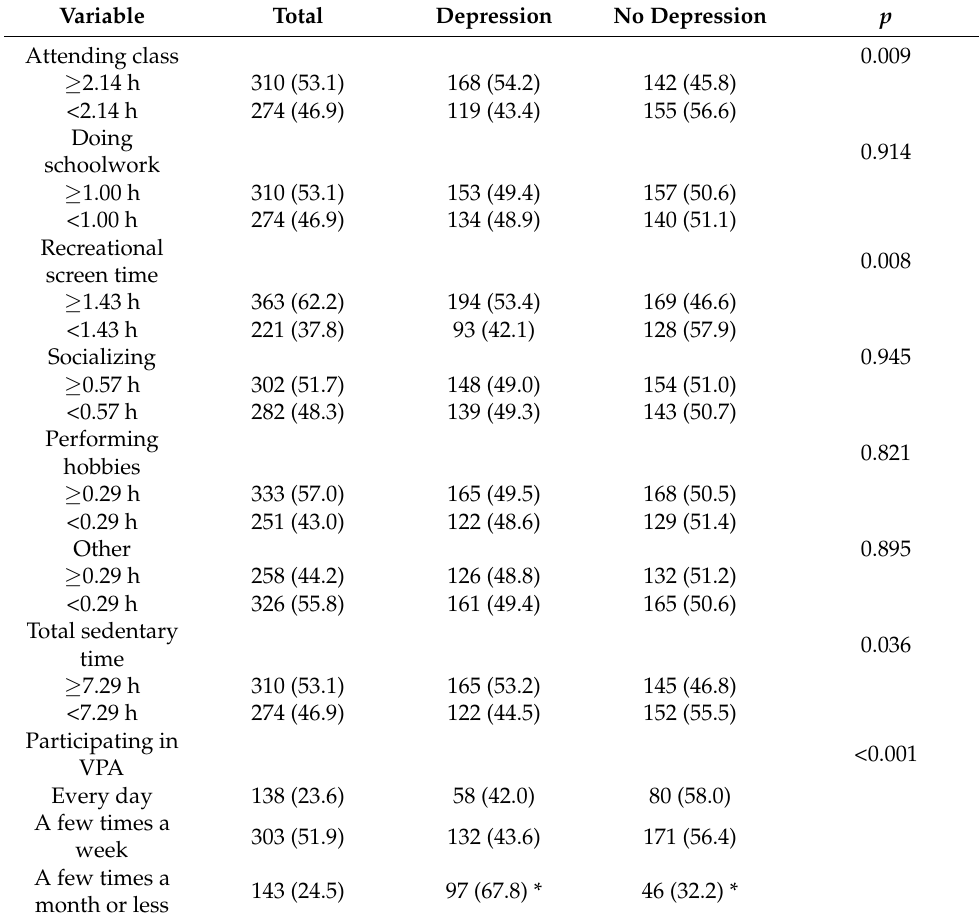
Table 4. Levels of sedentary behavior and frequency of vigorous physical exercise of participants by depression, n (%).